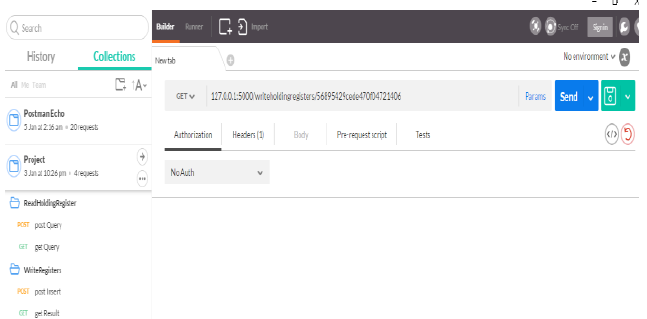
Figure 16: Postman extension for